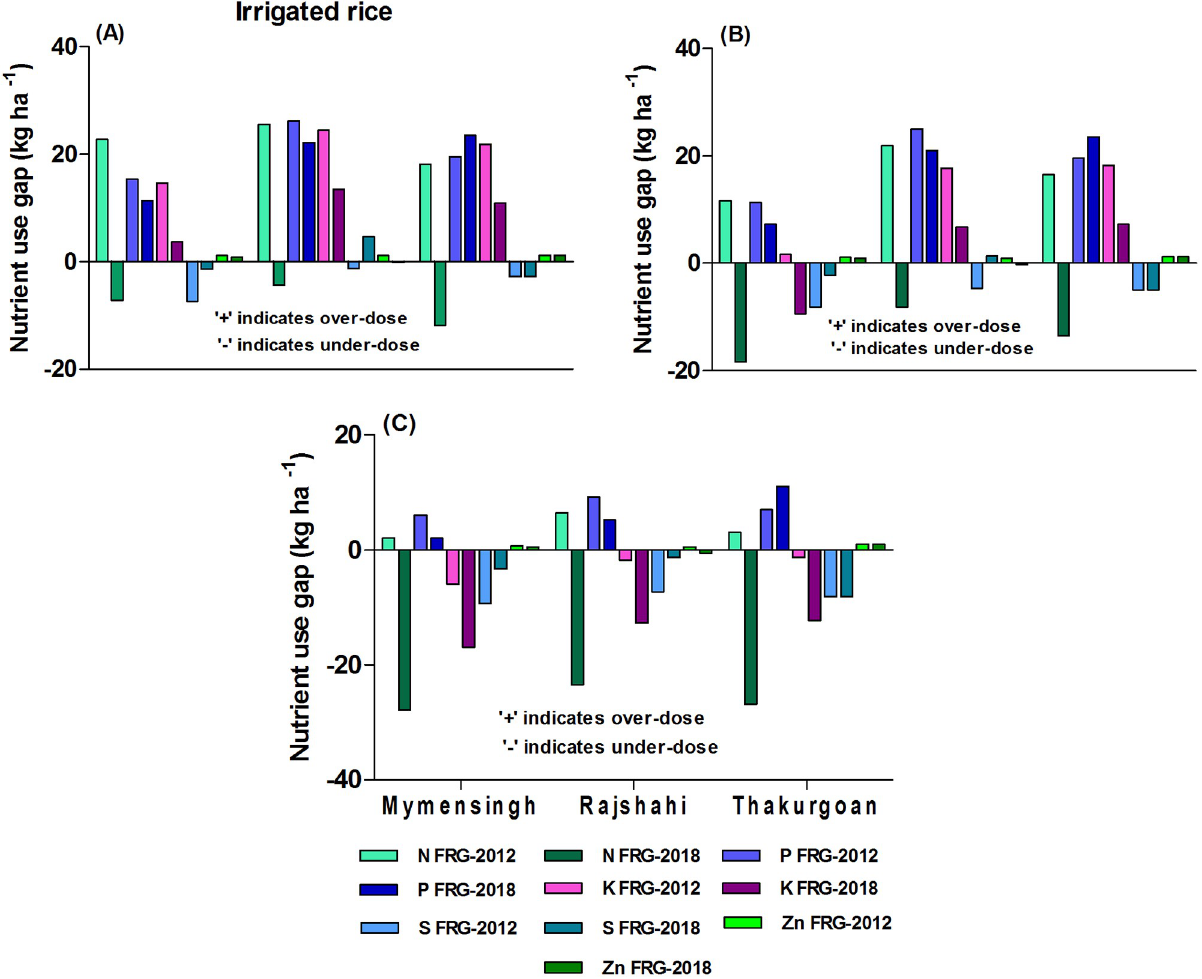
Fig 1. Farms’ current nutrient use gaps relative to FRG-2012 and FRG-2018 for irrigated rice: A) large-scale farms B) medium-scale farms C) small-scale farms for the irrigated rice-fallow-monsoon rice cropping pattern.